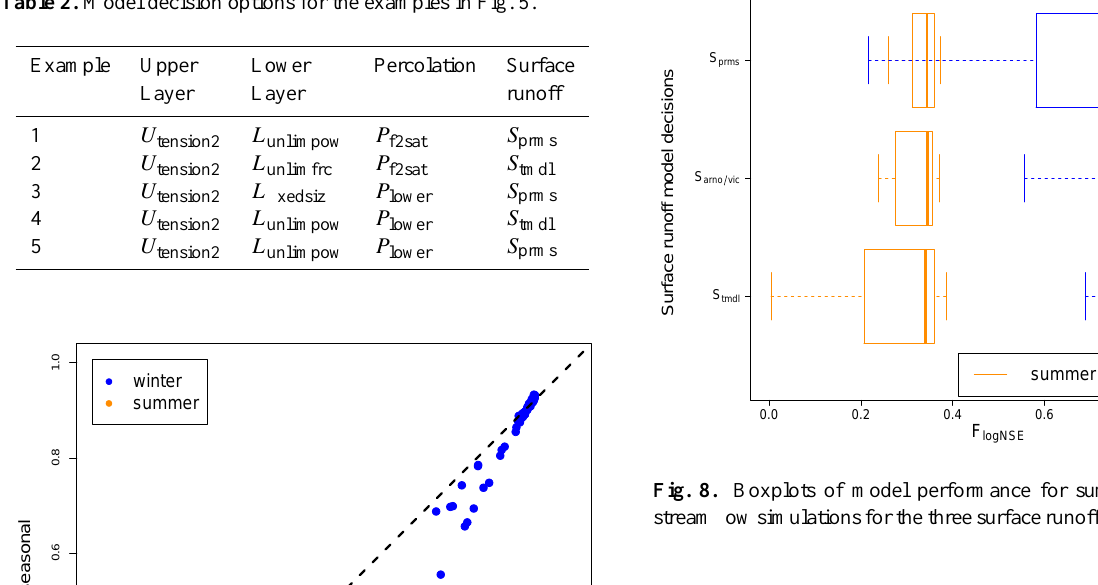
Table 2. Model decision options for the examples in Fig. 5.